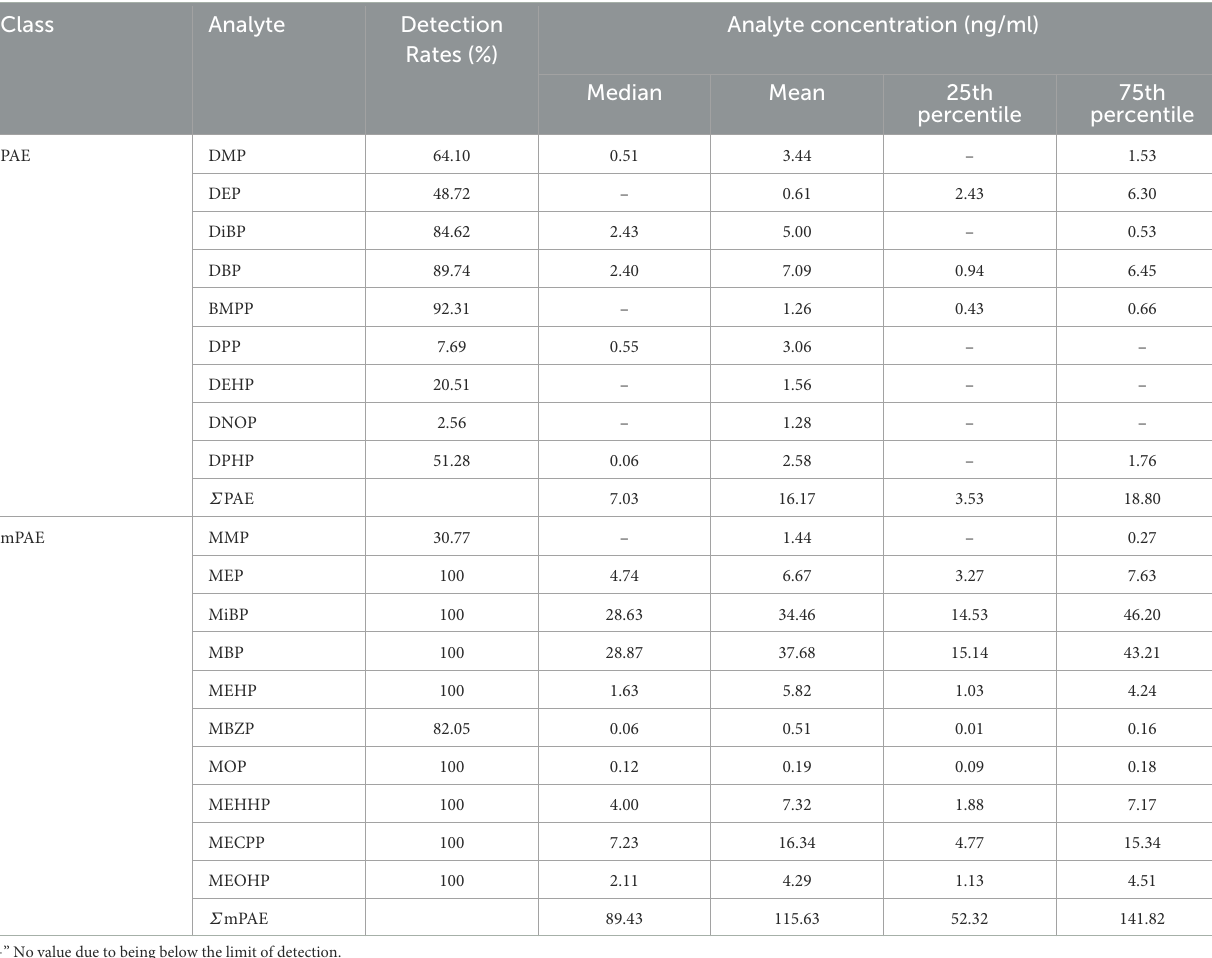
TABLE 2 Urinary concentrations (ng/ml) of PAEs and mPAEs in urine from Tianjin.